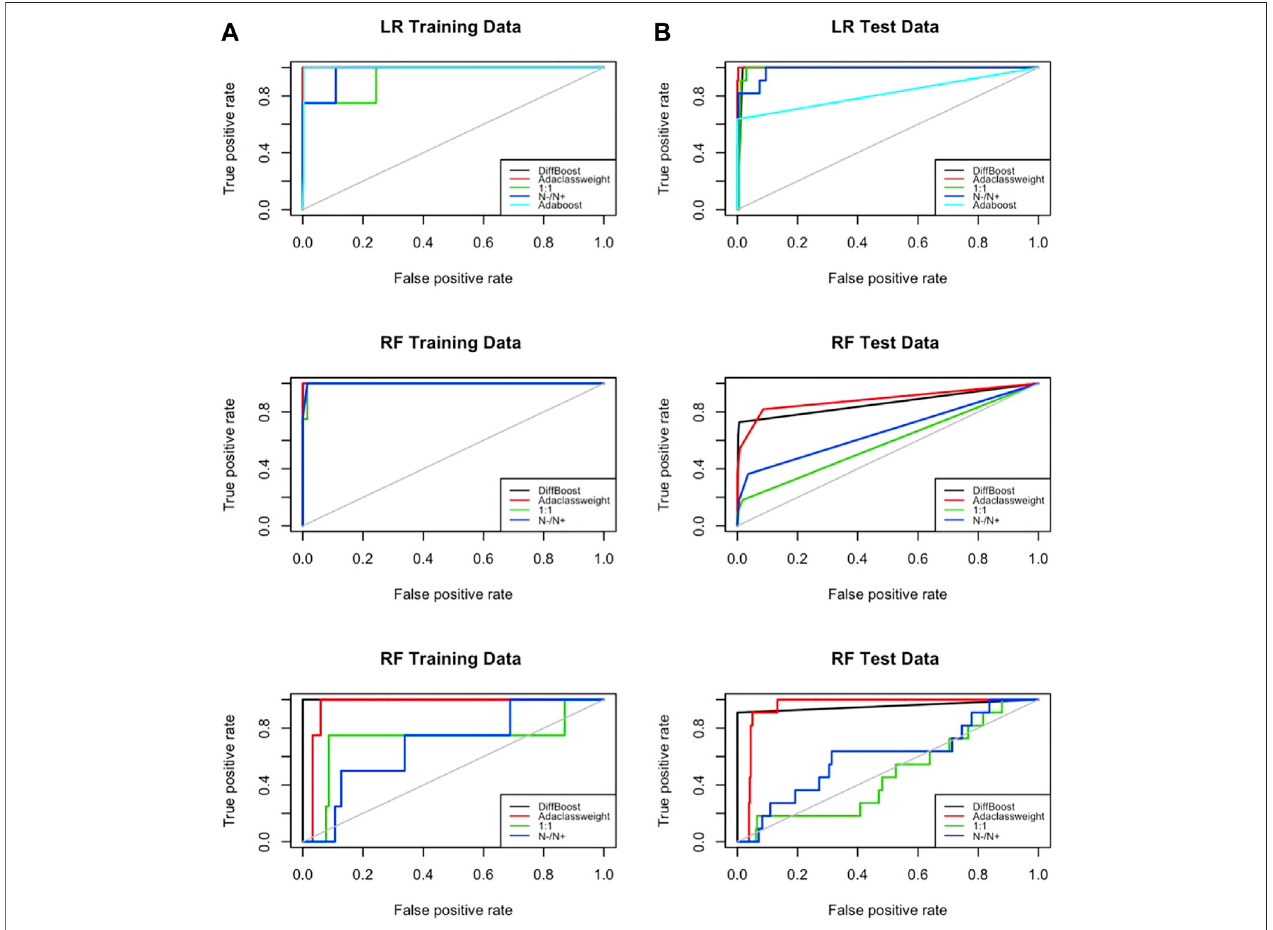
FIGURE3| ROContrainingdataandtestingdata.TestsaredoneontheIEEE39-bus powersystemdata.DiffBoostandAdaClassWeightbothhave alargerarea under the curve than other algorithms.